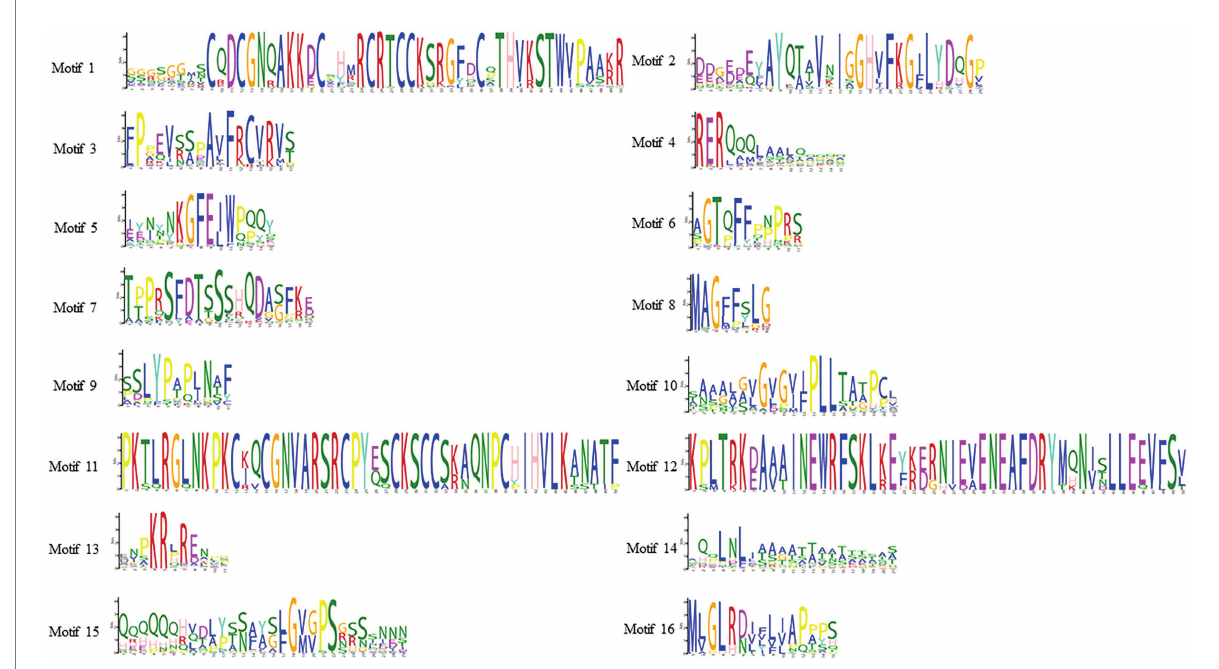
FIGURE 2 Sequence logos of conserved motifs in SHI/STY proteins. This logo represents the sequence of 16 motifs. The letters represent any amino acid, and the size represents how well it has been preserved at that location. The predicted motif sequence was obtained from the MEME website based on the sequences of SHI/STYs (http://meme-suite.org/tools/meme).